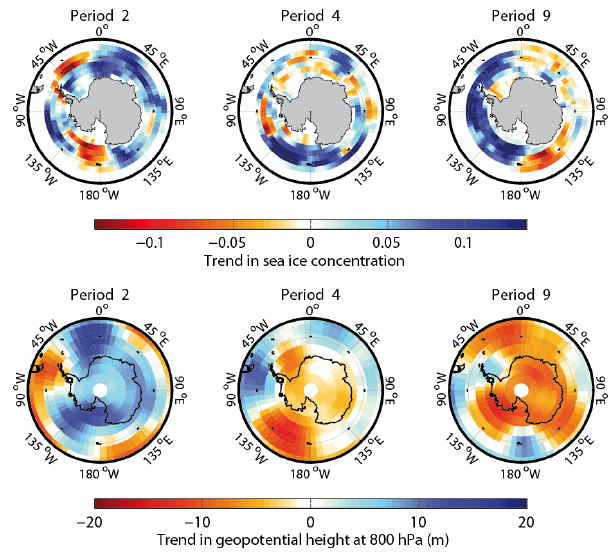
Figure 4. Trends in annual means ice concentration (top row) and in geopotential height at 800 hpa Fig. 4. Trends in annual mean ice concentration (top row) and in geopotential height at 800hpa (m) (bottom row) for the 3 selected (m) (bottom row) for the 3 selected periods among the 11 ones showing a large increase in Antarctic periods among the 11 ones showing a large increase in Antarctic sea sea ice extent, scaled to represent 30 year changes. The 11 corresponding figures for all the 11 ice extent, scaled to represent 30 year changes. The 11 correspond- periods are provided as supplementary material. ing figures for all the 11 periods are provided as supplementary ma-